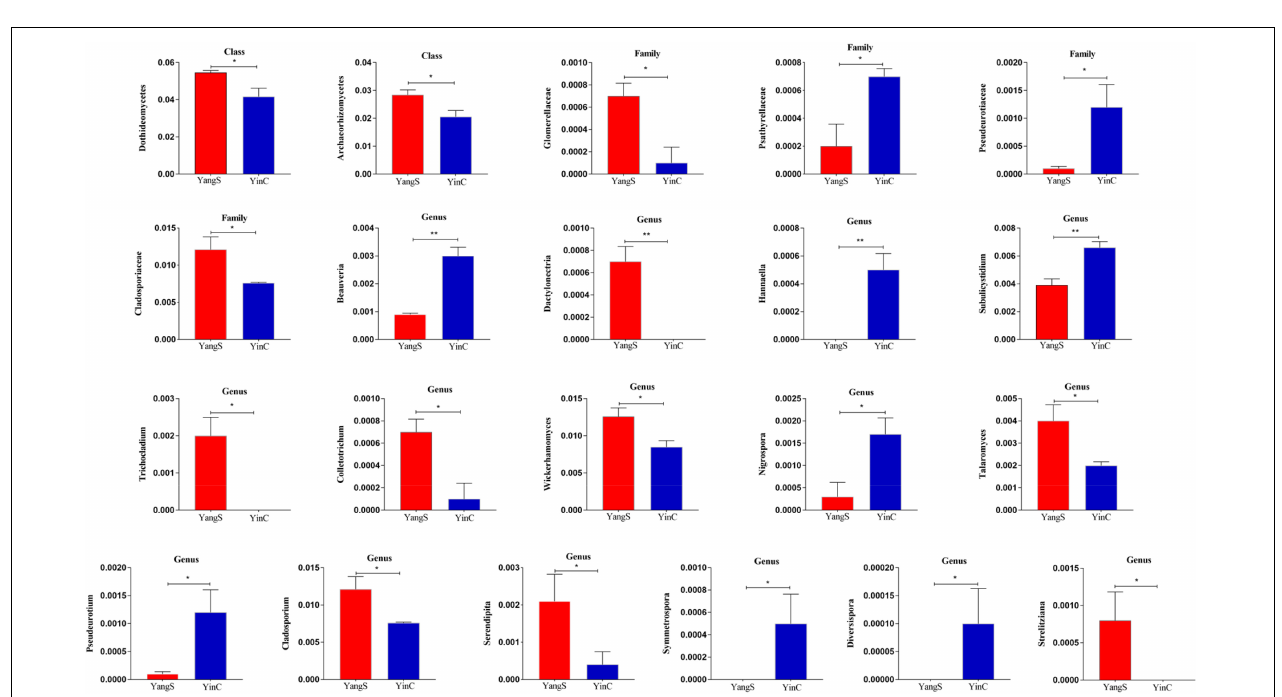
FIGURE 5 | Significant differences in fungal microbiota abundance. * p < 0.05; ** p < 0.01.